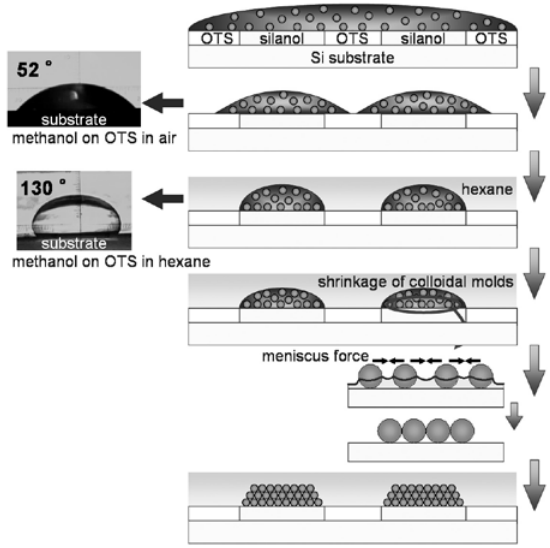
Fig. 1 Conceptual process for two-solution self-assembly method to fab- ricate patterned colloidal photonic